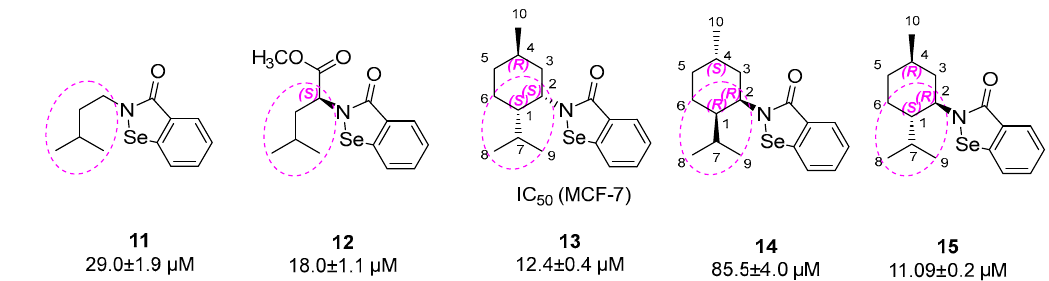
Figure 1. Structural elements influencing the reactivity of compounds 11 – 15 .